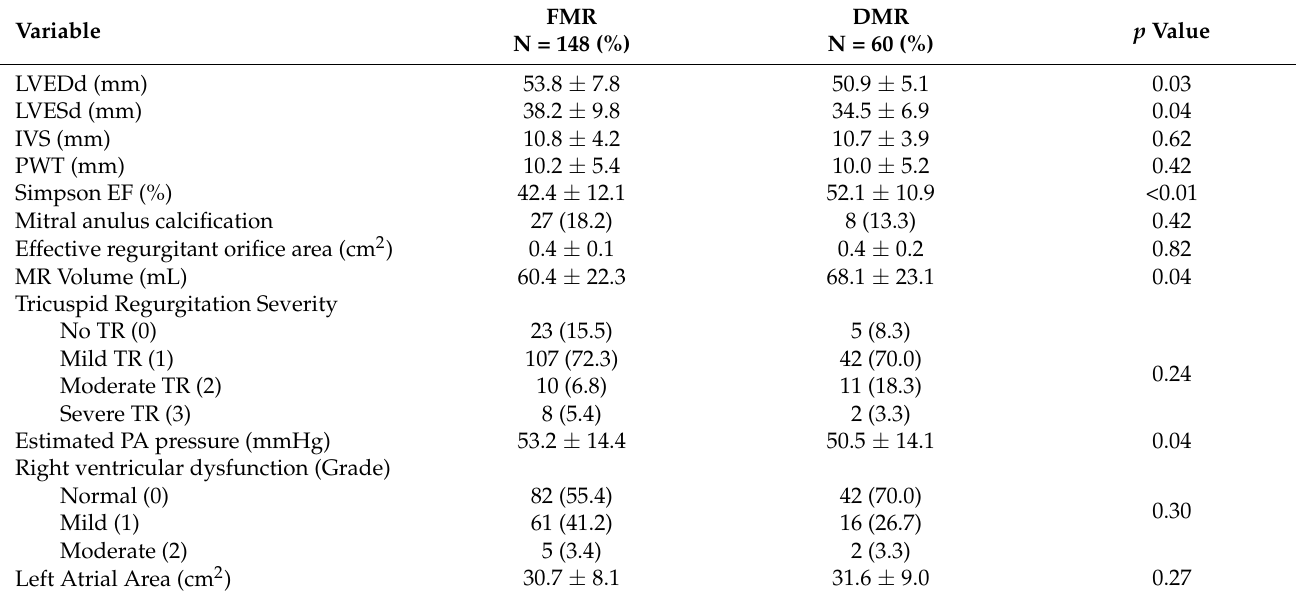
Table 2. Baseline Echocardiographic Characteristics.